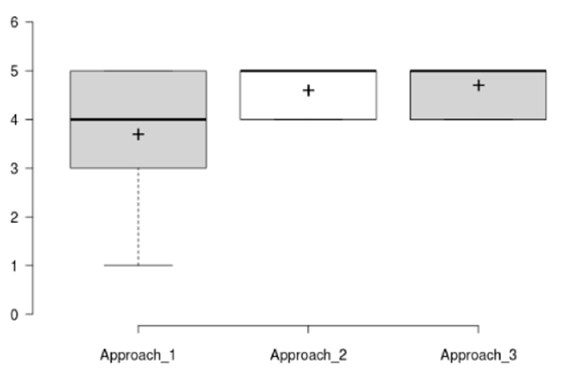
Figure 21. OBINTER Approach-related specific statement assessment results per participant. Line chart shows the score achieved in each question for each participant, where 1=’Strongly Disagree’ and 5=’Strongly Agree’. Figure 22. OBINTER Approach-related specific statement assessment results. Box plot showing overall scores and variability for the different results. The plus sign denotes the average value.